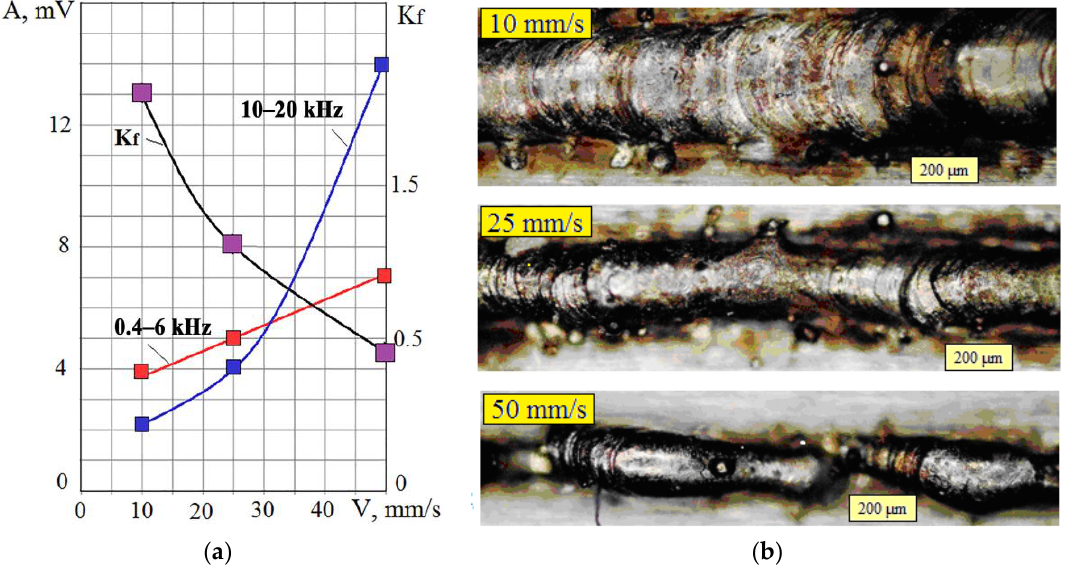
Figure 7. Change of RMS amplitude of the VA signal in the frequency ranges 0.4 – 6 kHz and 10 – 20 kHz and the K f ratio when changing the laser beam velocity (V) ( a ); photos of traces with the different laser beam velocity ( b ).